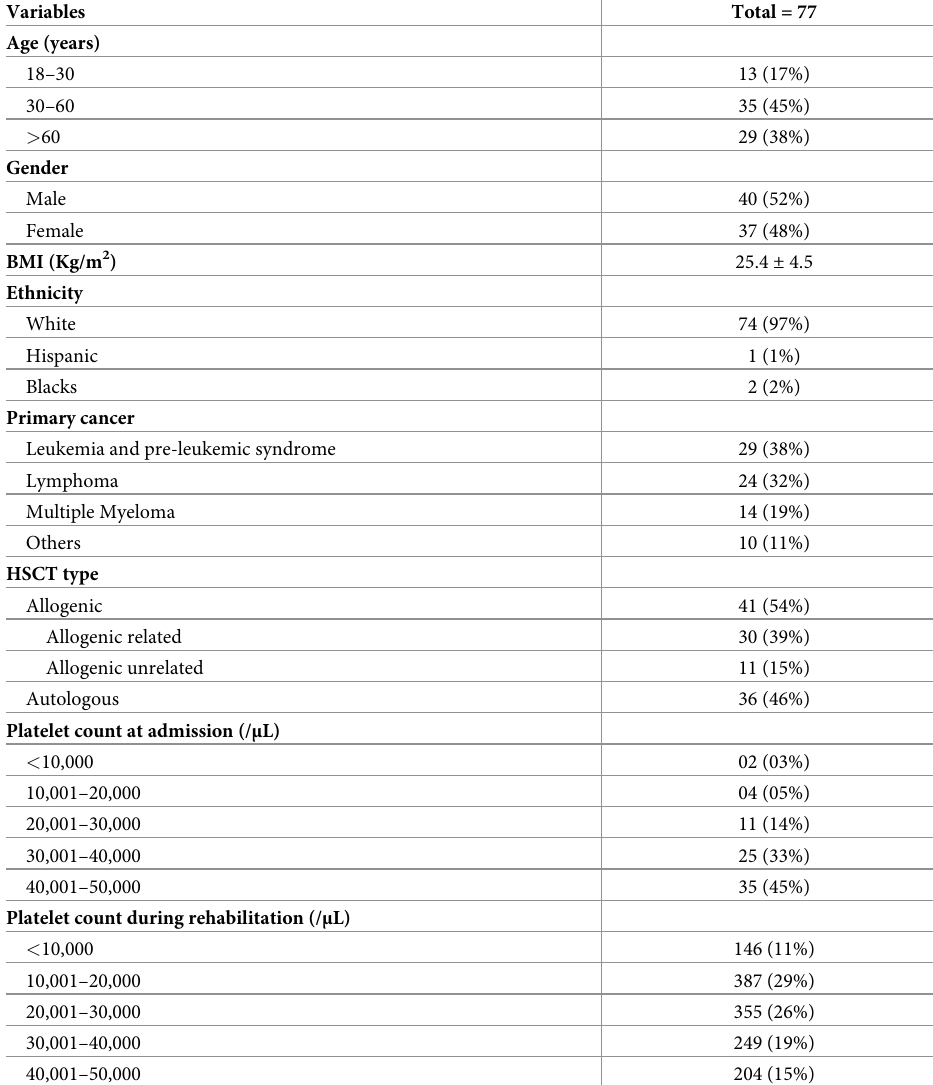
Table 1. Demographic and clinical characteristics of